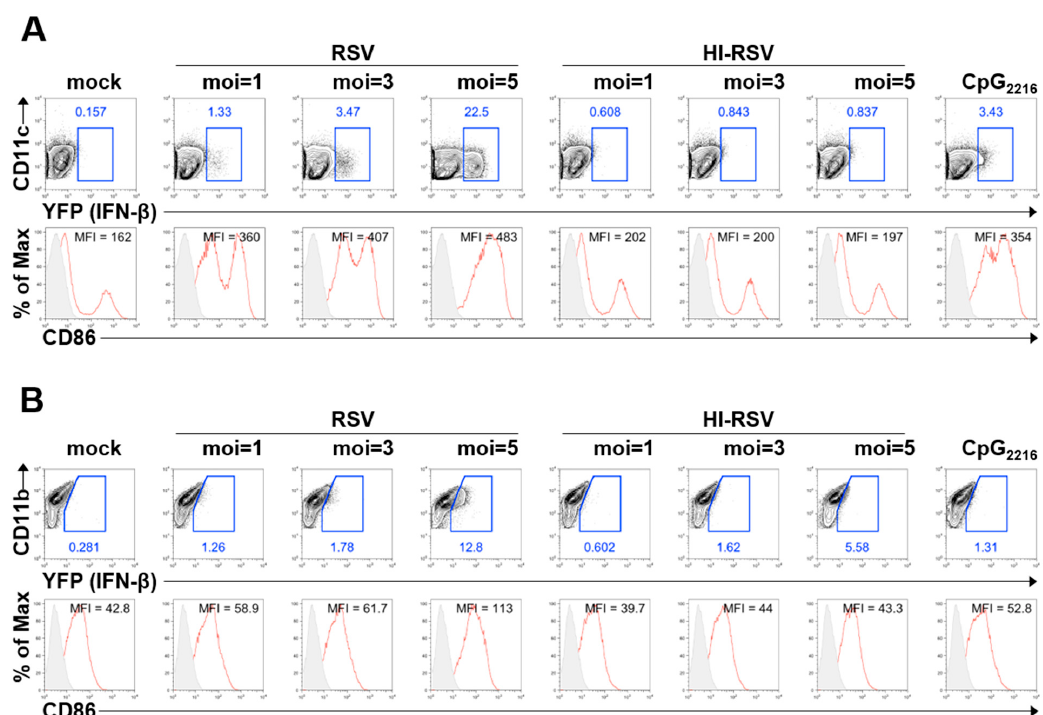
Figure 1. BM-DCs produce more IFN- β than BM-DMs do against RSV infection. ( A , B ) BM cells from IFN- β /YFP reporter mice are differentiated to BM-DCs with GM-CSF, or to BM-DMs with M-CSF. BM-DCs (A) or BM-DMs (B) were infected with the indicated dose of RSV, heat-inactivated RSV (HI-RSV), or 2.5 µ g/mL CpG 2216 . These cells were harvested 18 h after stimulation and analyzed for